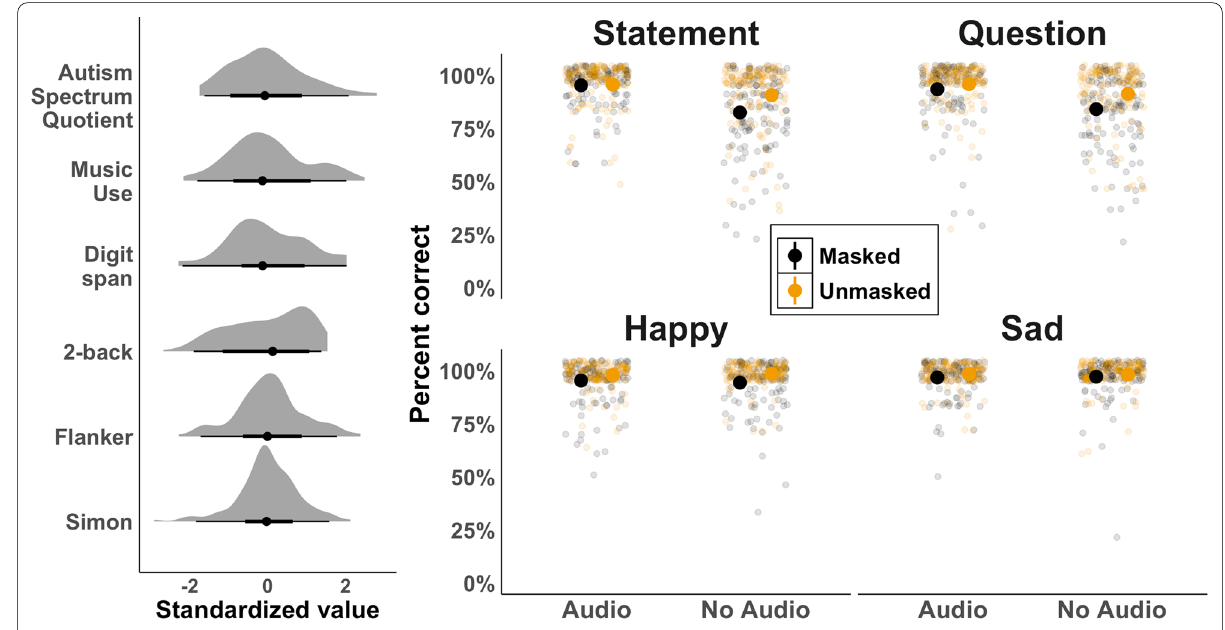
Fig. 3 Standardized individual predictors (left) and performance on eight prosody–mask–audio conditions in the prosody task